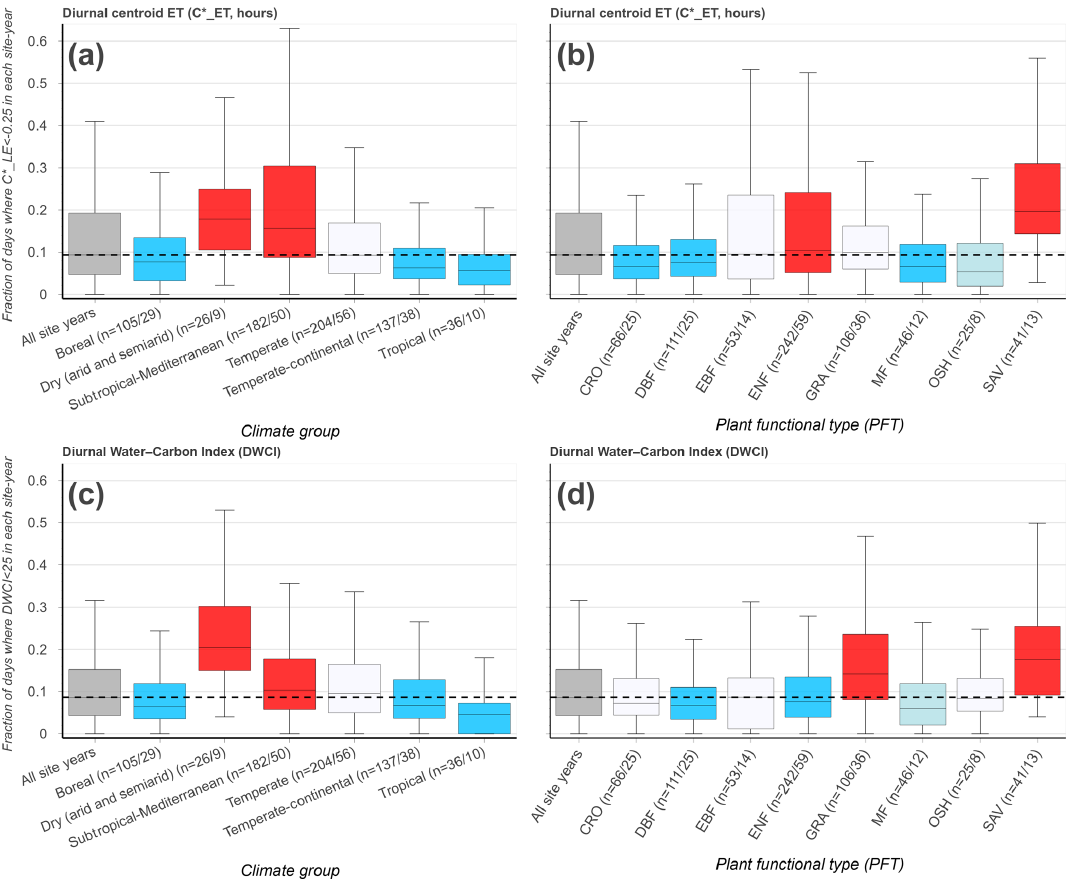
< − 0 . 25h, a, b ) and low Diurnal Water–Carbon Index (DWCI<25, c, d ) Figure 4. The frequency of morning-shifted diurnal centroids ( C ∗ ET for 690 FLUXNET site years/192 sites, grouped by climate group (a, c) and plant functional type (b, d) . Group labels on x axis indicate the number of site years/sites ( n = site-years/sites) for each category. The dashed line is the median for all site years. Color shade indicates level of significance, with light colors and dark colors having p values <0.10 and <0.05, respectively (Wilcoxon–Mann–Whitney two-sample rank-sum test); red and blue colors indicate distributions higher and lower, respectively, compared to data from all sites excluding the group. Only site years with at least 20 data points and groups with more than 5 site years were